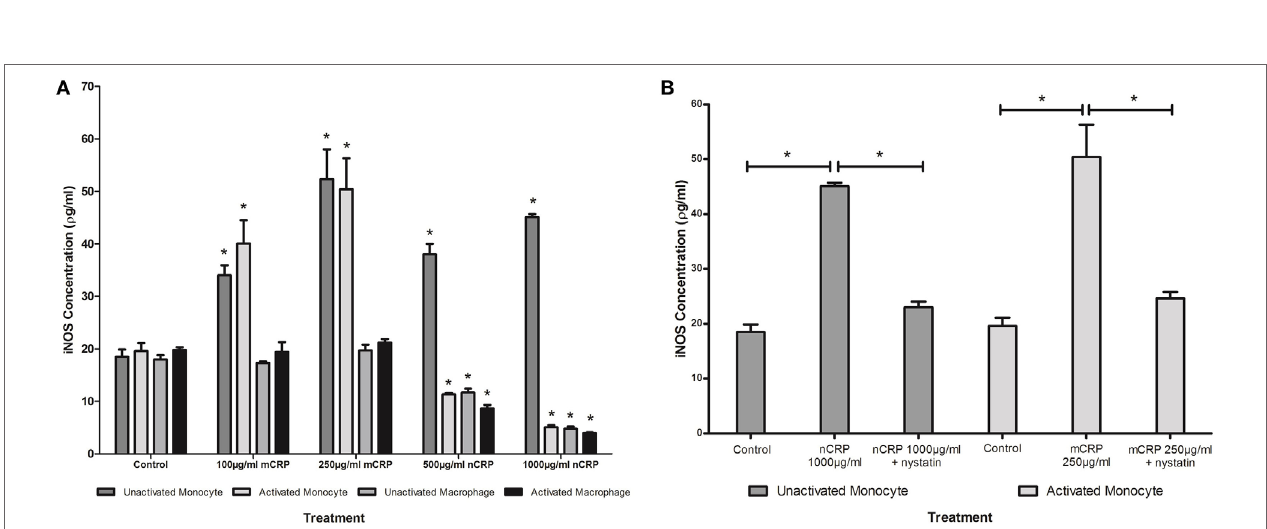
FigUre 5 | Effect of C-reactive protein (CRP) isoforms on inducible nitric oxide synthase (iNOS). Levels of iNOS production by several cell states (monocyte, lipopolysaccharide (LPS)-activated monocyte, macrophage, and LPS-activated macrophage) were differentially mediated by CRP isoforms in a concentration- dependent manner (a) . Nystatin significantly reversed CRP-mediated iNOS production in unactivated monocytes treated with nCRP and activated monocytes treated with mCRP (B) . *Indicates significant differences ( P < 0.05; n = 12) in iNOS production compared with corresponding negative controls (a) or CRP/nystatin treatments (B) . Errors bars represent the SEM.